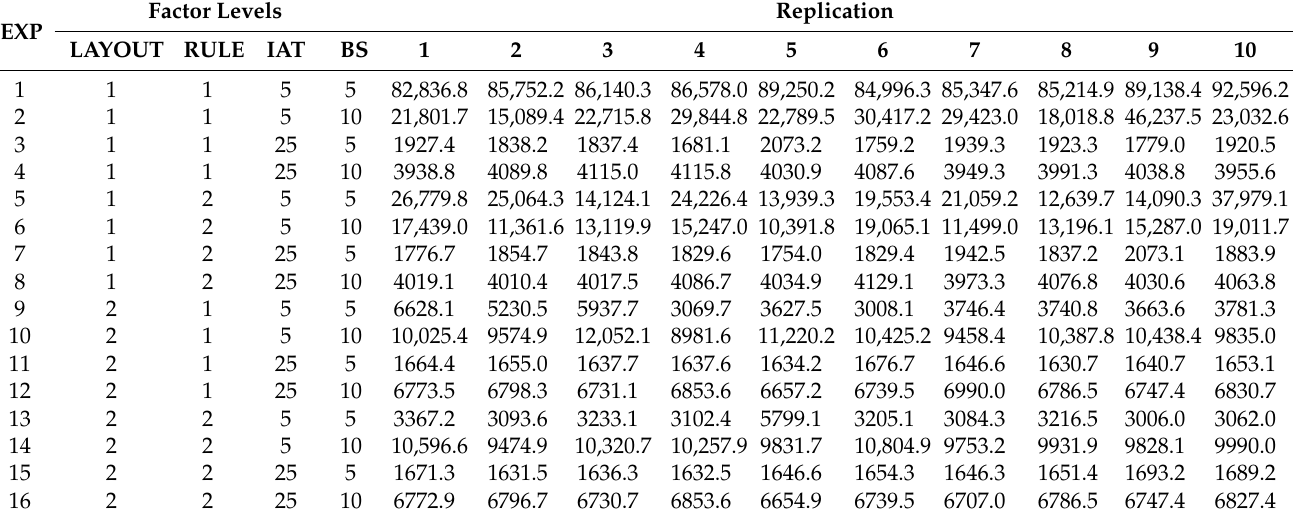
Table A4. WT simulation results according to DoE.